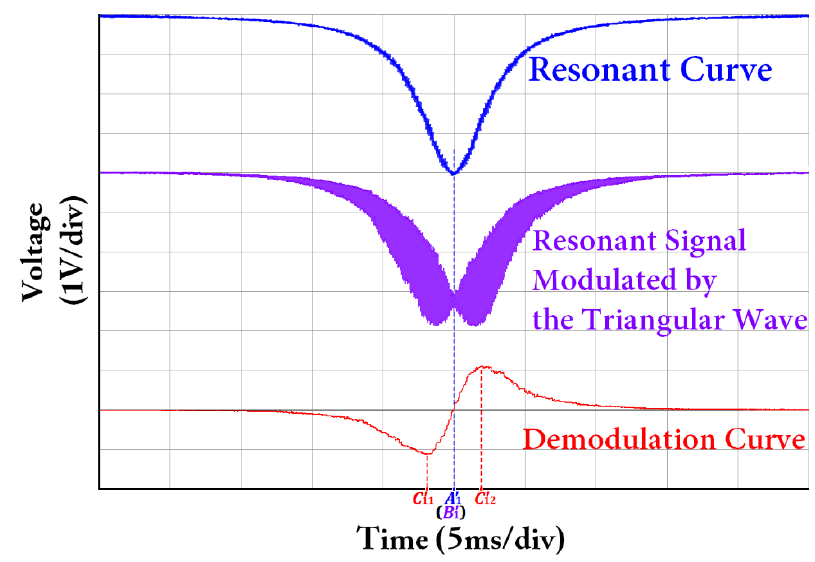
Figure 8. Measured resonant curve, resonant signal modulated by the triangular wave, and demodulation curve, when using coupler C2 #2 connected to FRR.